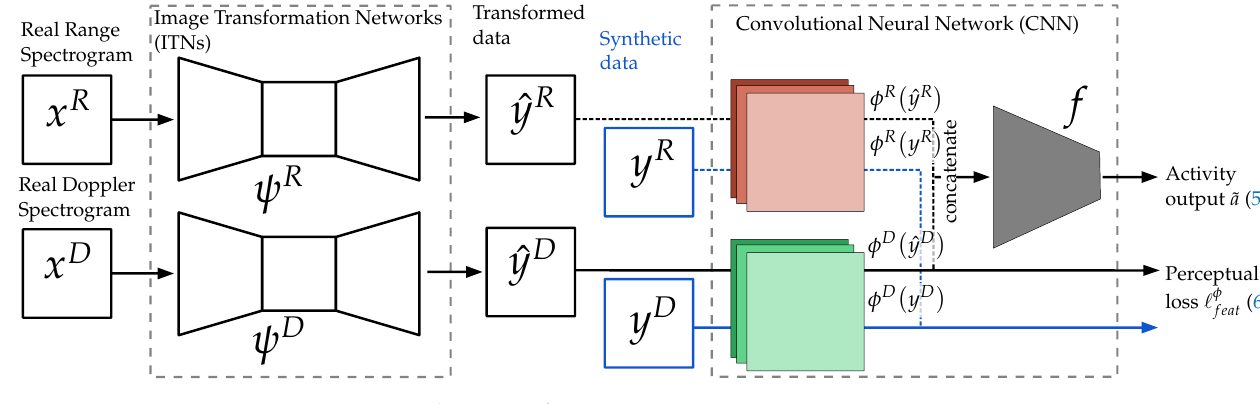
Figure 7. Architecture of